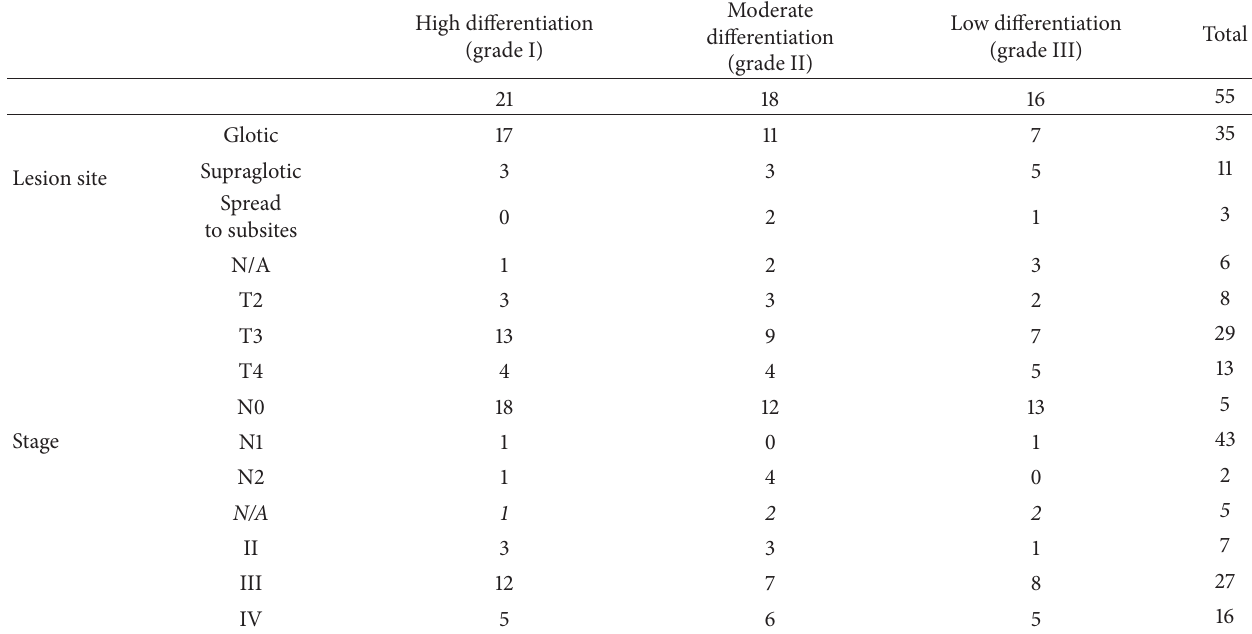
Table 1: Site, stage, and grade distribution of laryngeal tumor lesions. High